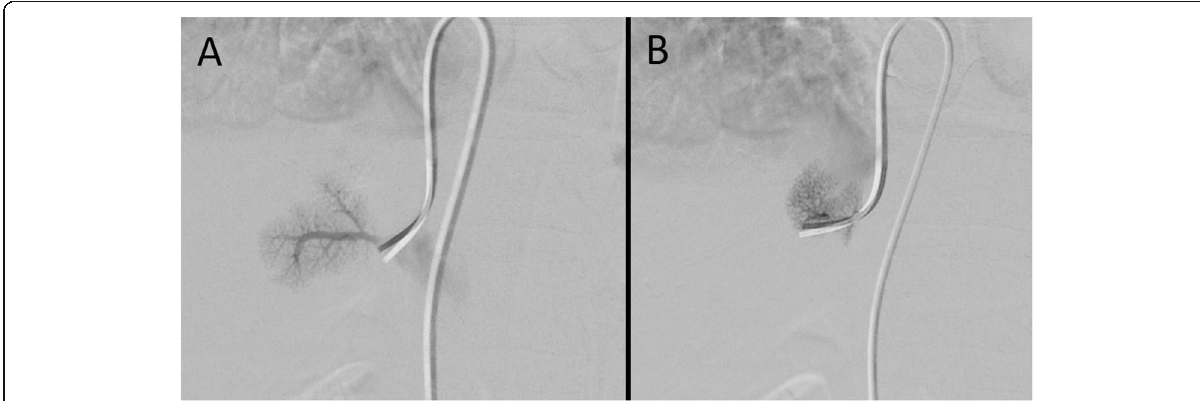
Fig. 3 Venographic appearance of an accessory hepatics vein. Images A + B, taken in the same patient show two different accessory hepatic veins. The parenchymal staining and lack of capsular/communicating veins are consistent with hepatic vein rather than adrenal vein cannulation. Occasionally, one may see intrahepatic communication to larger hepatic